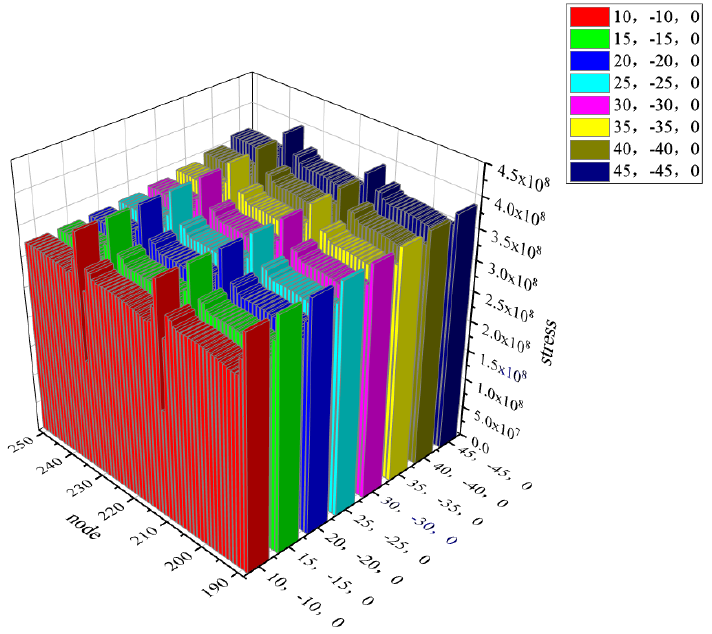
Figure 13. The stress changes of different ply angles under the thickness of 0.002 m.